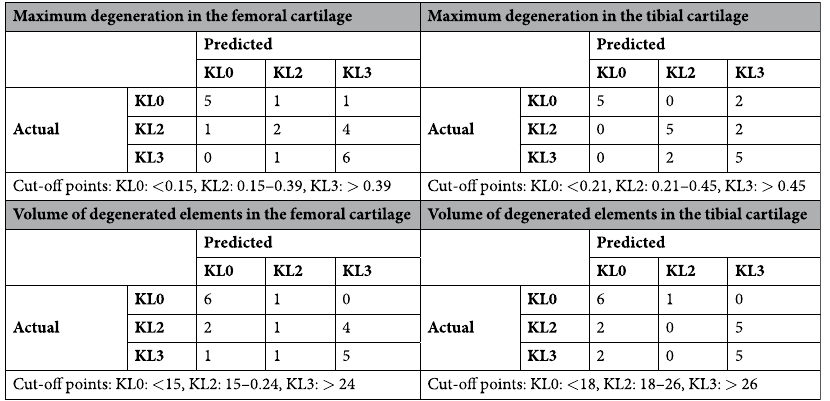
Table 1. Matrices of classification errors for maximum degenerations and volumes of degenerated elements of femoral and tibial cartilage. Cut-off values for predicted KL grades were chosen from the ROC curves so that the Youden index was maximized (see statistical analysis from the Methods